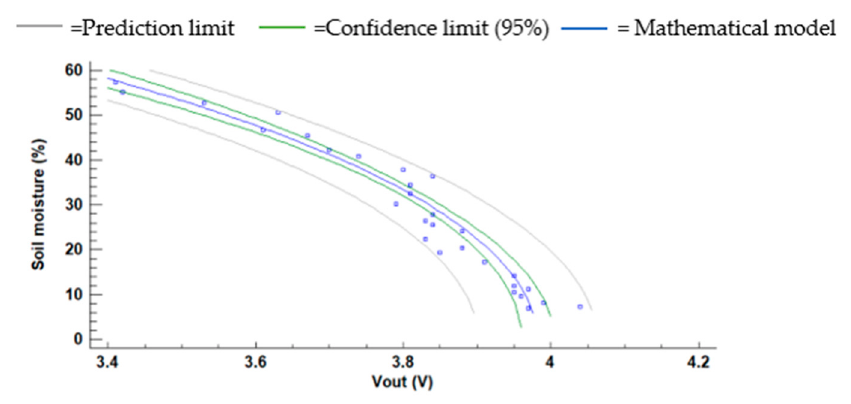
Table 8. Mathematical models to prototype NP1 frequency 750 kHz.